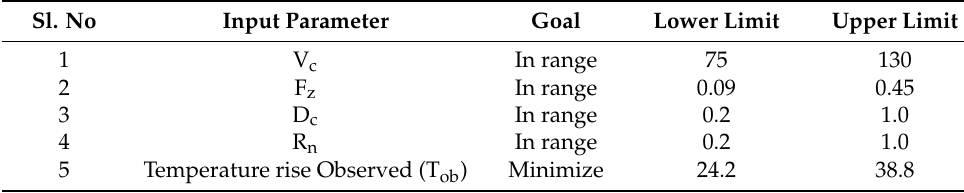
Table 4. Selection of factors and responses for desirability.